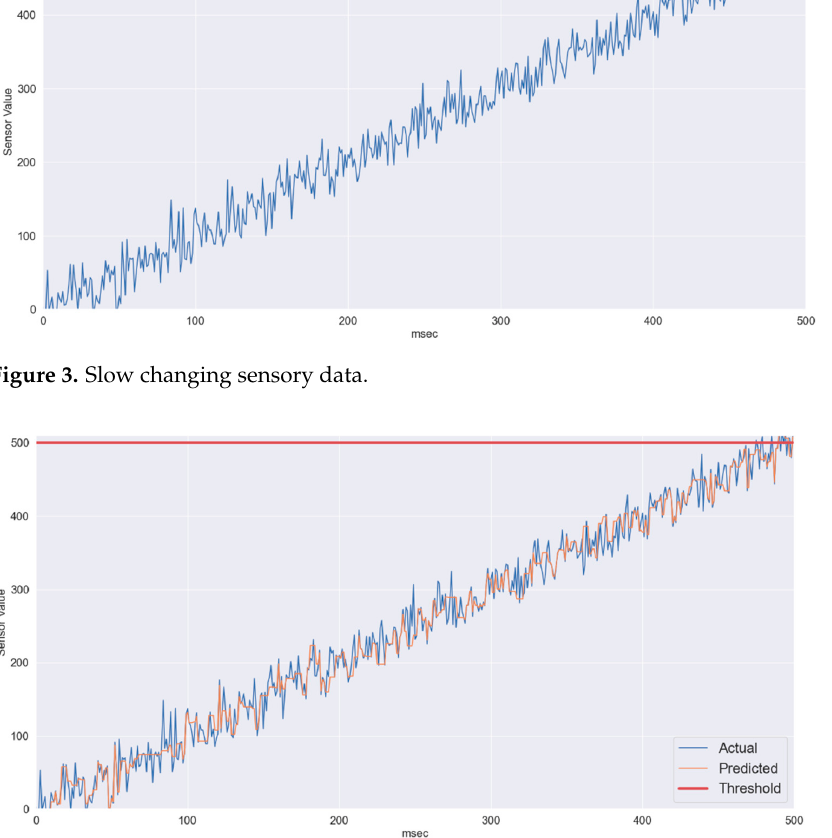
Figure 4. XGB-slow varying data: Predicted vs. Actual.